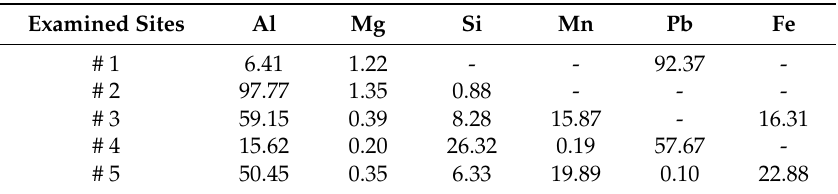
Figure 10. SEM micrographs of an SAE sample surface, before EIS corrosion test ( a ) and after 6 h of immersion in the aerated testing solution ( b ). Table 4. Chemical composition (wt%) obtained from energy dispersive X-ray (EDX) analysis of the particles indicated in Figure 10.